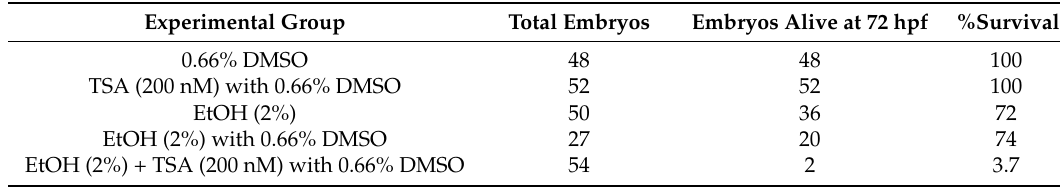
Table 1. EtOH and Trichostatin A (TSA) is a Lethal Combination for Zebrafish Embryos. Experimental Group Total Embryos